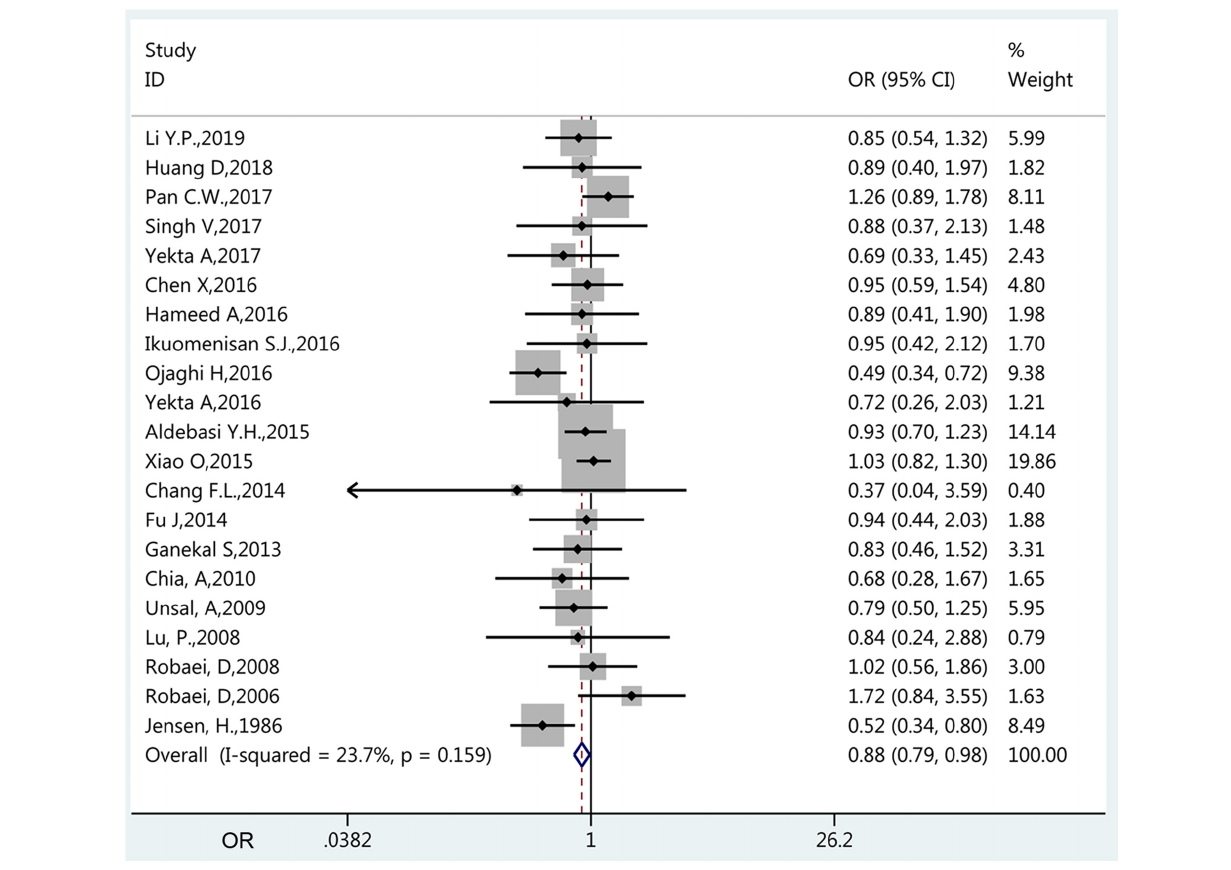
FIGURE 4 | Forest plot of prevalence of amblyopia of female vs. male. The small diamonds are the odds ratios (ORs), the line represents the 95% confidence intervals (CIs), and the gray boxes represent the proportional sample size. The x -axis represents the ORs. This analysis only included the studies ( n = 20) that compared males vs.